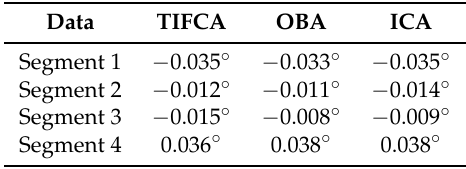
Table 5. The final roll angle error of four